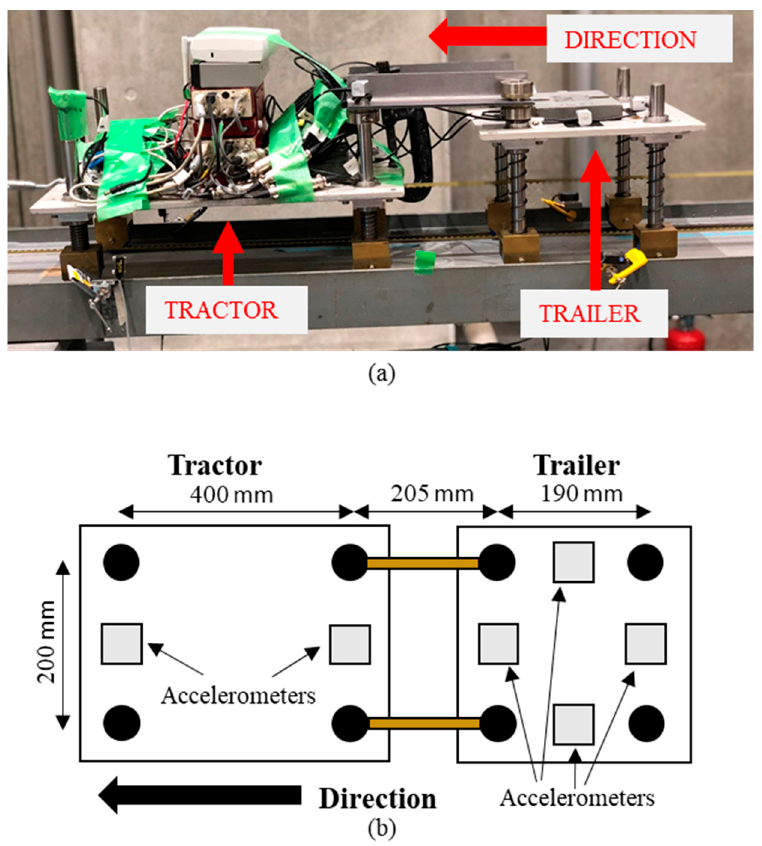
Figure 10. ( a ) Experimental vehicle consisting of two-axle tractor towing a two-axle trailer, ( b ) Plan view showing vehicle